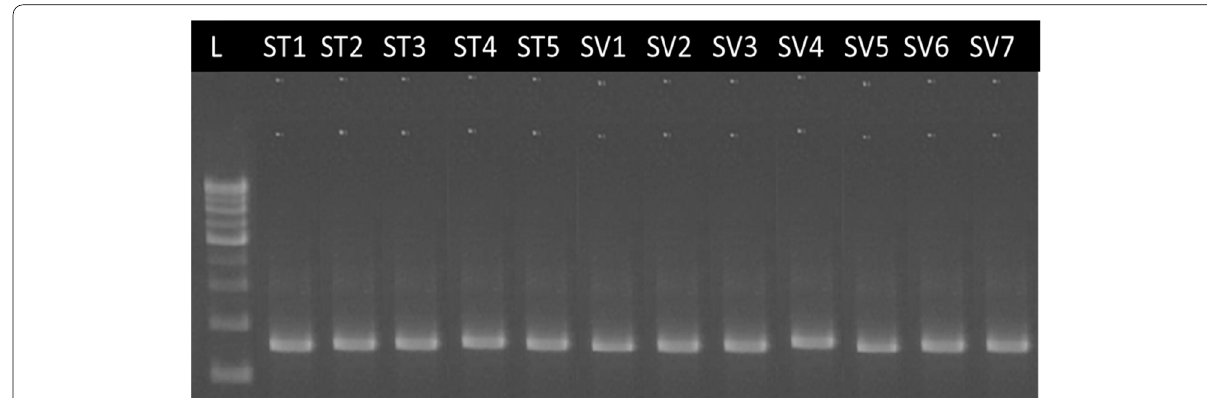
Fig. 1 Agarose gel showing amplification of rbcL gene